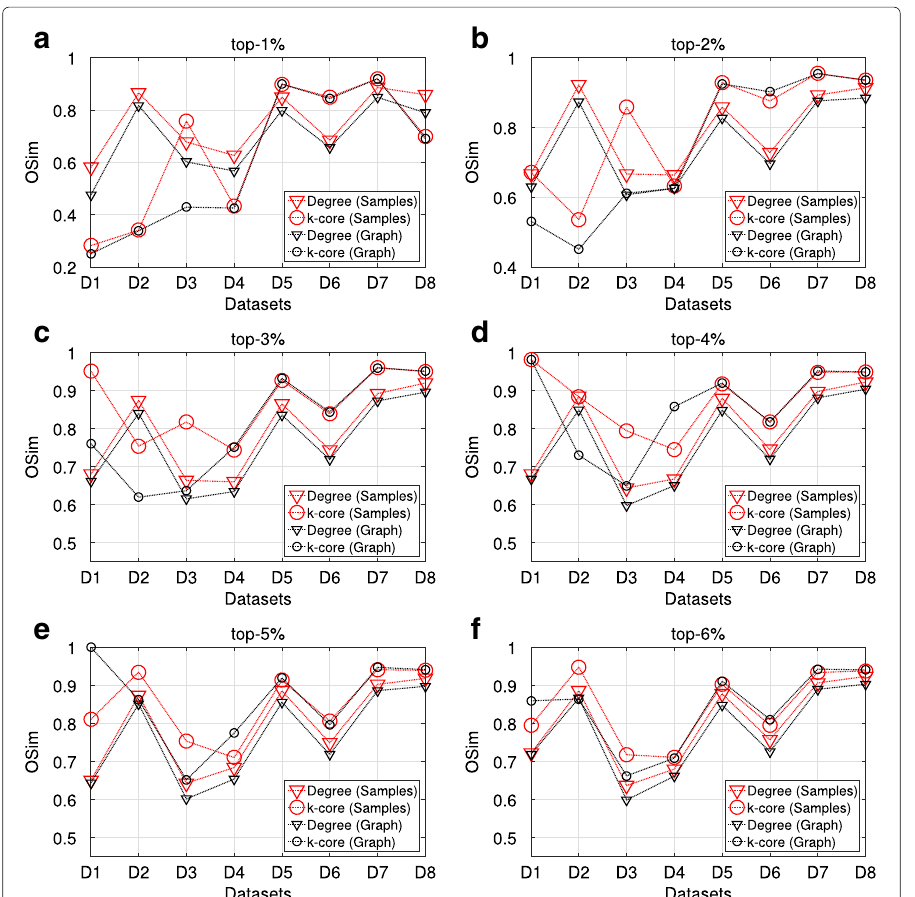
Fig. 4 Top-k nodes similarity, SIS epidemic. a - f Average OSim values in terms of degree centrality and k-core obtained from the maxRD samples, as well as from the original